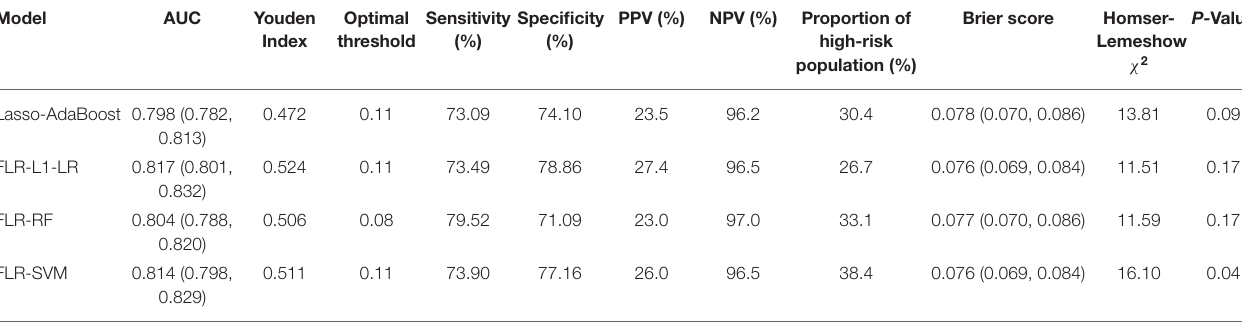
Optimal Sensitivity Specificity PPV (%) NPV (%) Proportion of Index threshold (%) (%)